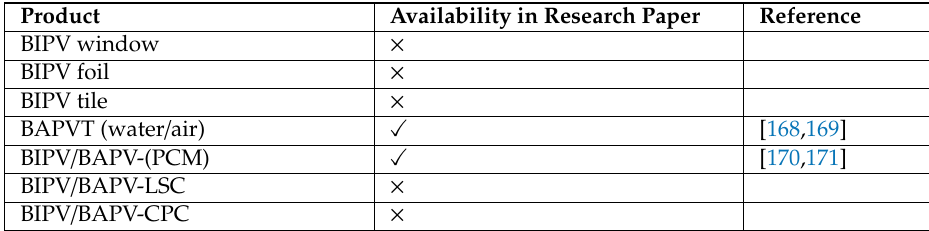
Table 3. Availability of BIPV / BAPV products in